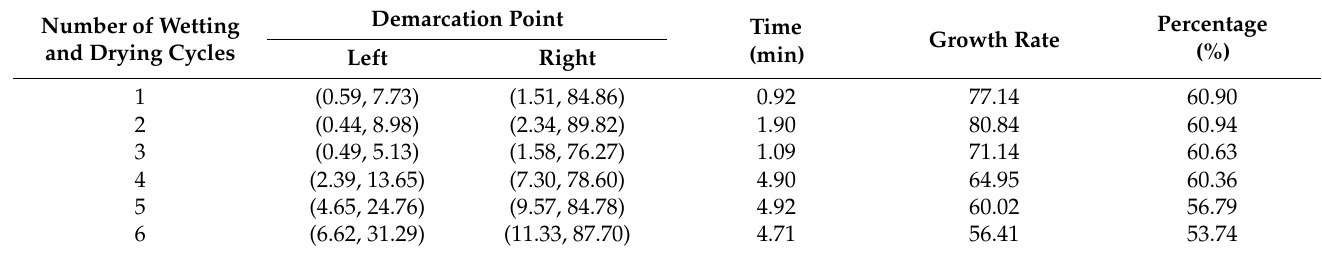
Table 2. Coordinates of inflection points predicted by the Richards model for forecasting the rate of soil detachment as affected by the number of wetting and drying